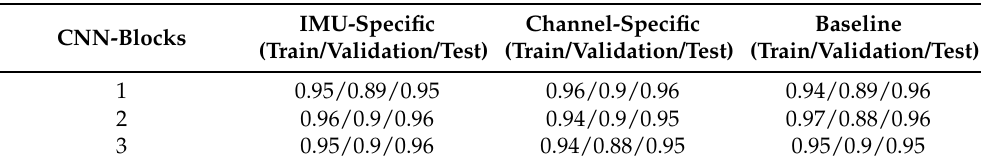
Table 2. Results of the evaluation of different IMU-specific architectures. Displayed met- rics are the arithmetic mean of the macro F1-scores of the 5-fold CV achieved on the train-